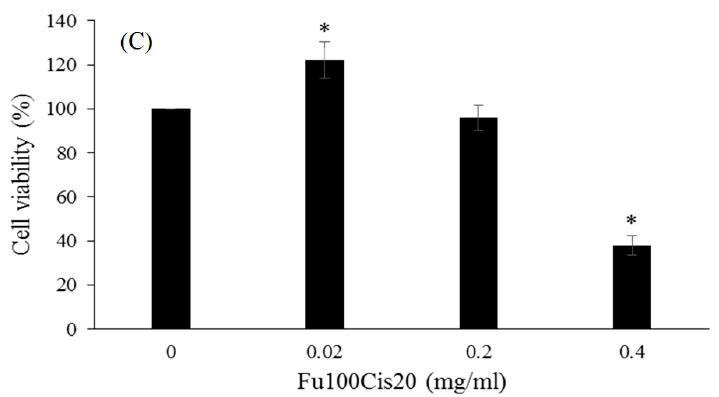
Figure 2. Cell viability results of ( A ) cisplatin; ( B ) fucoidan and ( C ) Fu100Cis20 in RAW264.7 cells for 24 h. Values were expressed as mean ± SD, n = 5. * p < 0.05 when compared with 0 mg/mL group.